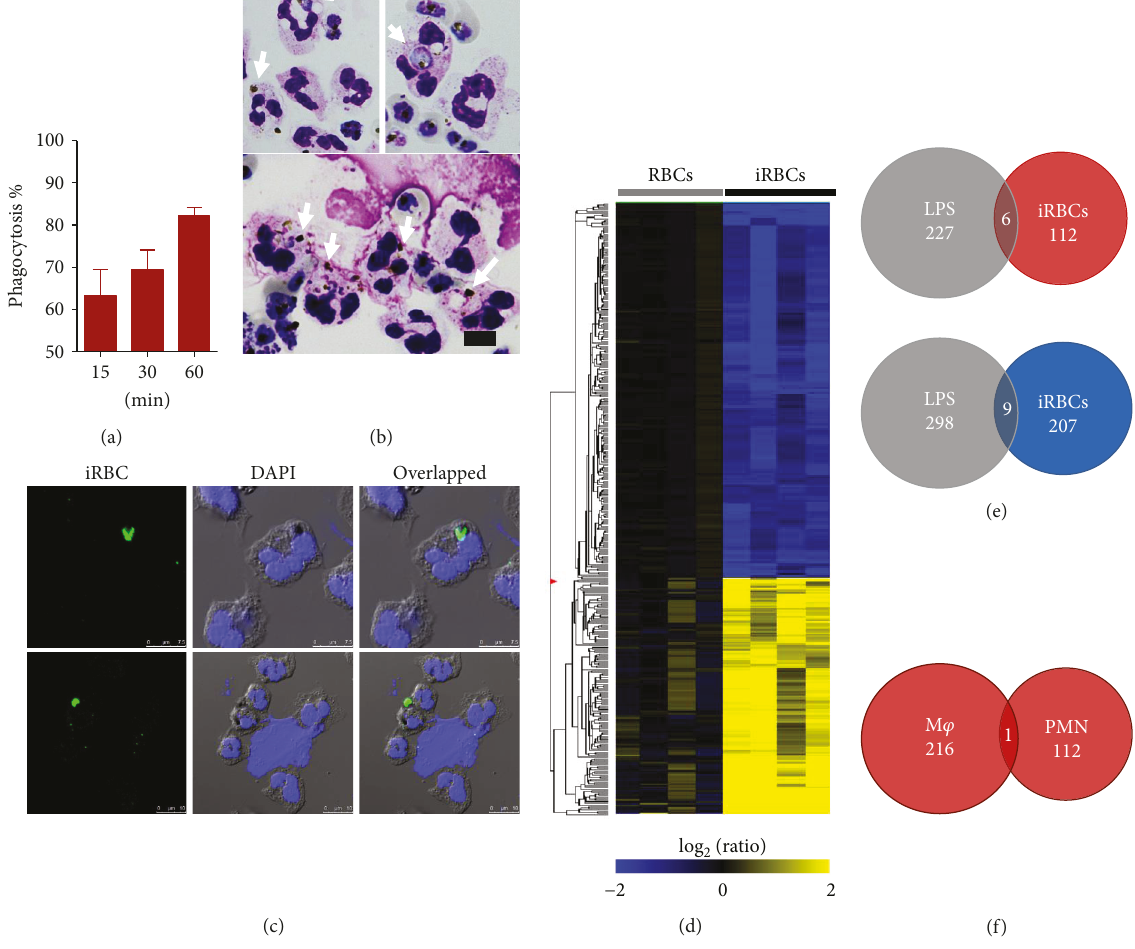
Figure 1: Response of human PMNs to iRBCs. (a) Percentage of PMNs phagocytizing iRBCs at di ff erent time points of incubation. Each bar represents the mean ± SEM for each group ( n = 4 ). (b) Neutrophils phagocytizing iRBCs or malaria pigment as stained by Giemsa. Arrows indicate phagocytized iRBCs or pigment. Freshly isolated neutrophils were cultured with enriched iRBCs onto coverslips, and their phagocytic activity was examined at di ff erent time points after staining with Giemsa. (c) PMNs phagocytizing iRBCs (upper panels) and releasing NETs after coculture with iRBCs (lower panels). PMNs on the coverslips were stained with speci fi c antibodies and examined by means of confocal microscopy. The scale bar is indicated on each image. (d) Gene pro fi le of human neutrophils as assessed by microarray analysis. Clusters of downregulated genes and upregulated genes of neutrophils cultured for 1 h with human nonparasitized RBCs or enriched iRBCs ( n = 4 ). (e) Venn diagram analyses for the comparison genes regulated in PMNs after stimulation with iRBCs or LPS. The upper panel is for upregulated genes, and the lower panel for downregulated genes. (f) Venn diagram analyses for the comparison genes regulated in macrophages and PMNs phagocytizing